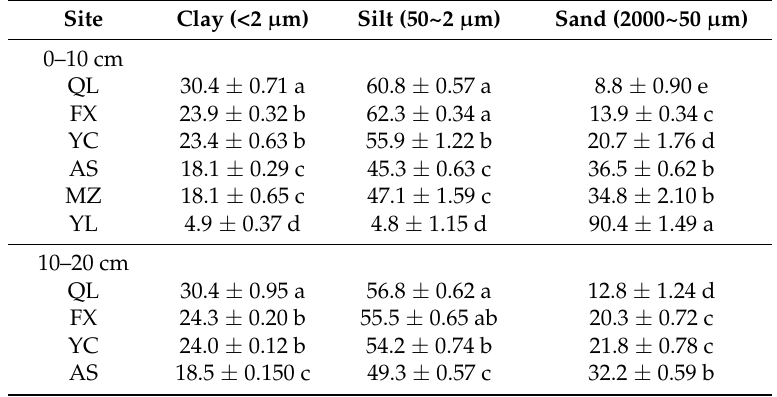
Table 3. Volume contents of sand, silt, and clay of PSD at different sampling sites in our